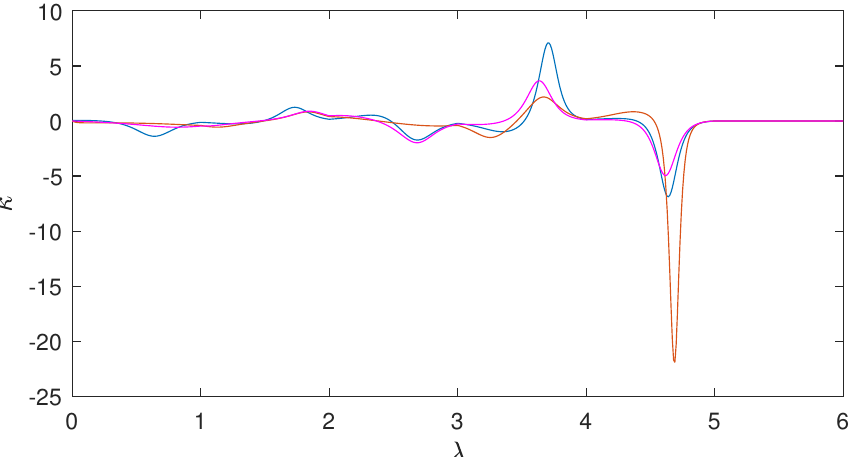
Figure 5. Example 1: the curvature as a function of the curve parameter λ . The colours correspond to the ones in Figure